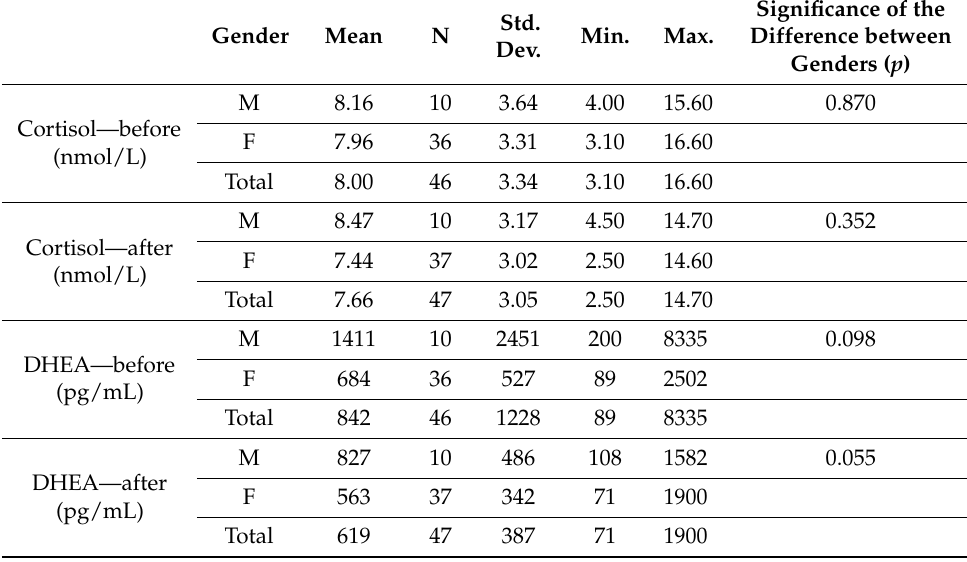
Table 1. Average concentrations of the two stress-indicating hormones cortisol and DHEA before and after forest therapy. Gender Mean N